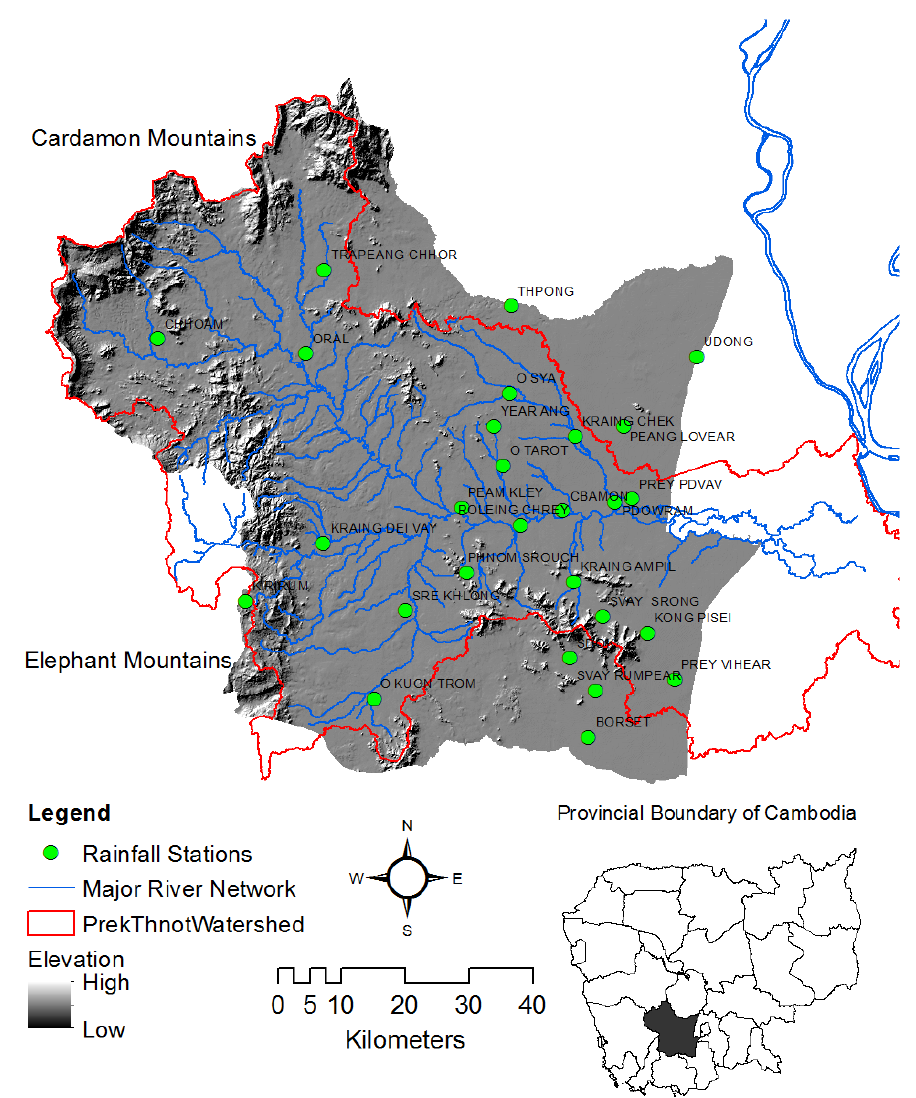
Figure 2. Kampong Speu Province. Sources: rainfall stations from fieldwork; major river network from Mekong River Commission; delineation of the Prek Thnot Watershed from GDEM data obtained from the HEC-GeoHMS program; elevation data from the Aster GDEM; and provincial boundaries from the National Geographic Department of